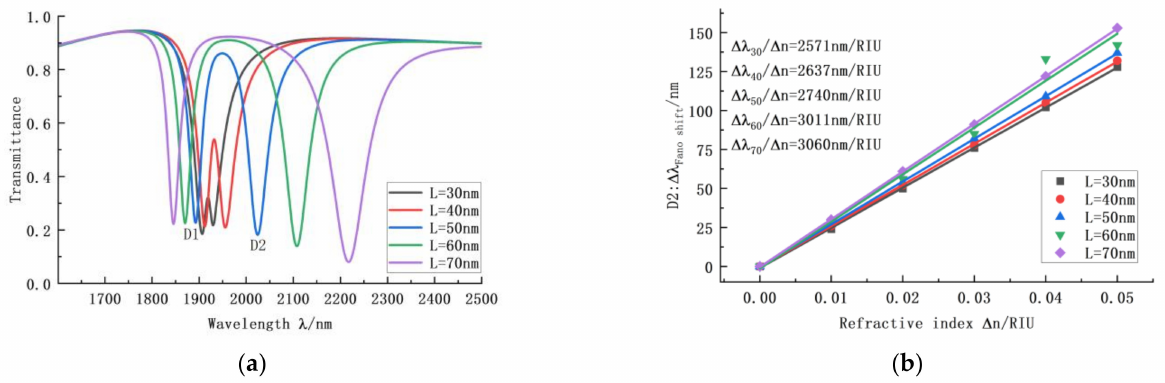
Figure 5. ( a ) Transmission curve spectrum when L is changed. ( b ) Sensitivity of the fit to the D2 trough as L changes.